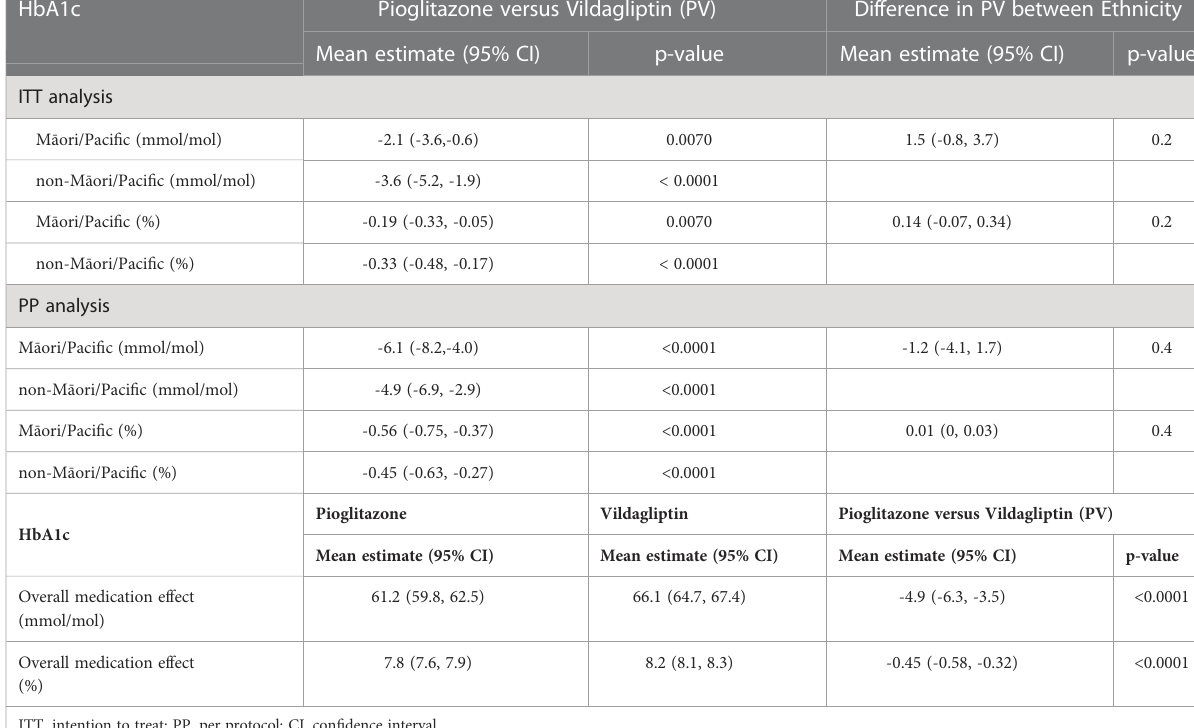
TABLE 3 The estimated medication effects on HbA1c and its interaction with ethnicity (primary outcome analysis).